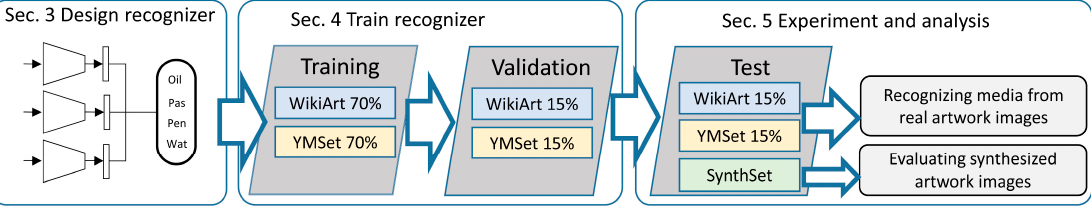
Figure 4. The process of our approach.